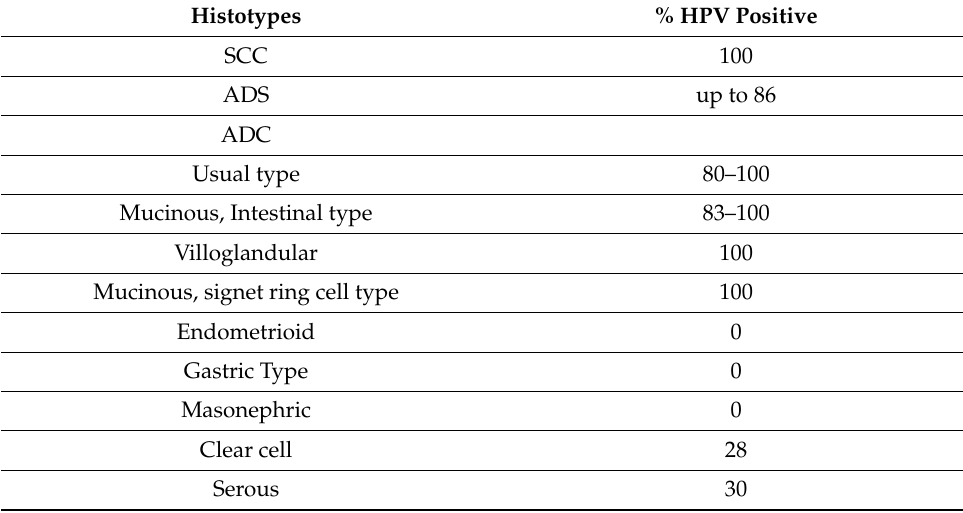
Table 2. HPV prevalence in different histotypes of cervical cancer